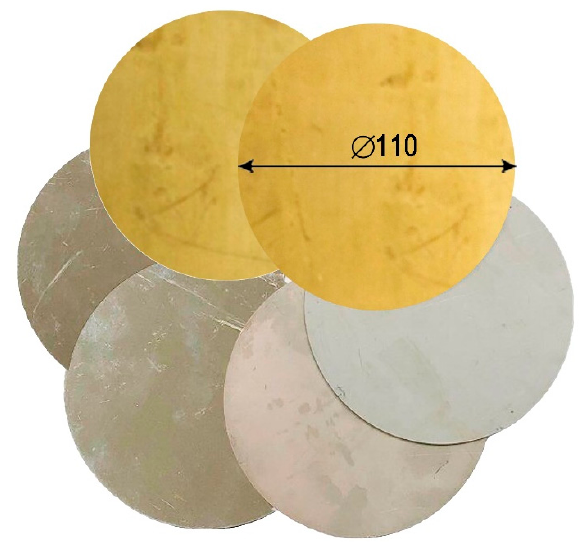
Figure 2. Experimental workpieces.